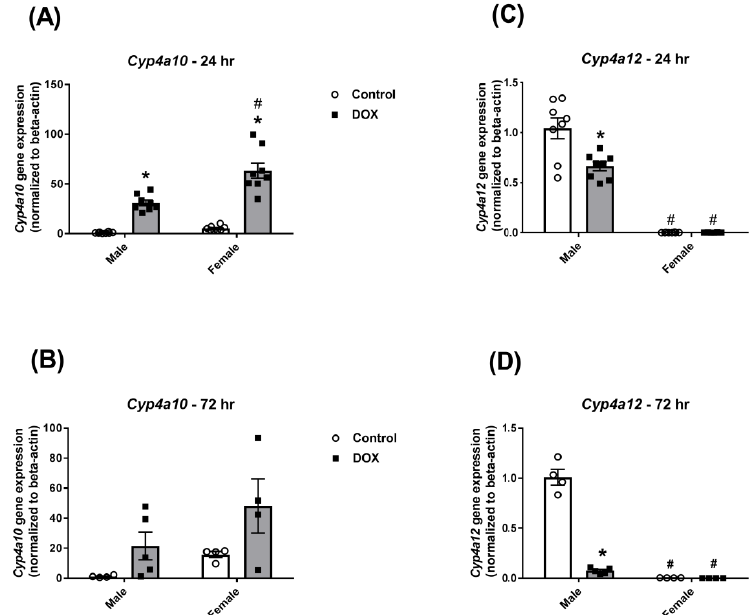
Figure 6. E ff ect of DOX treatment on the gene expression of the Cyp4a sub-family in the liver. Livers